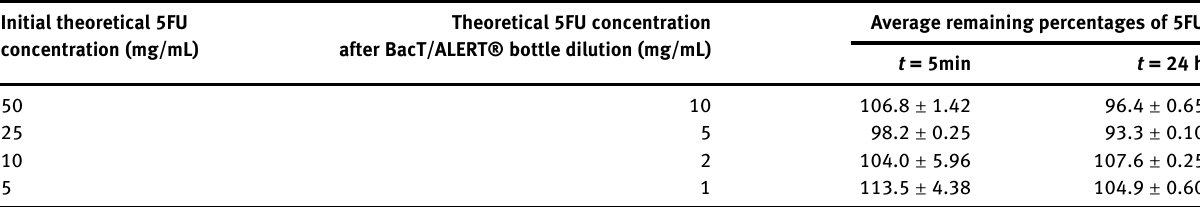
Table  :  FU remaining percentage after R  treatment in BacT/ALERT® media bottles. Initial theoretical 